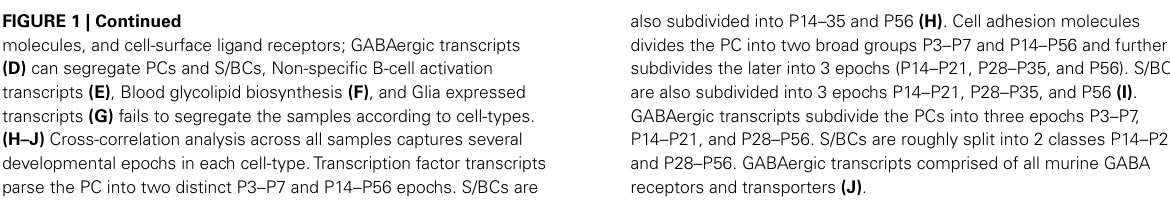
FIGURE 1 | Continued molecules, and cell-surface ligand receptors; GABAergic transcripts (D) can segregate PCs and S/BCs, Non-specific B-cell activation transcripts (E) , Blood glycolipid biosynthesis (F) , and Glia expressed transcripts (G) fails to segregate the samples according to cell-types. (H–J) Cross-correlation analysis across all samples captures several